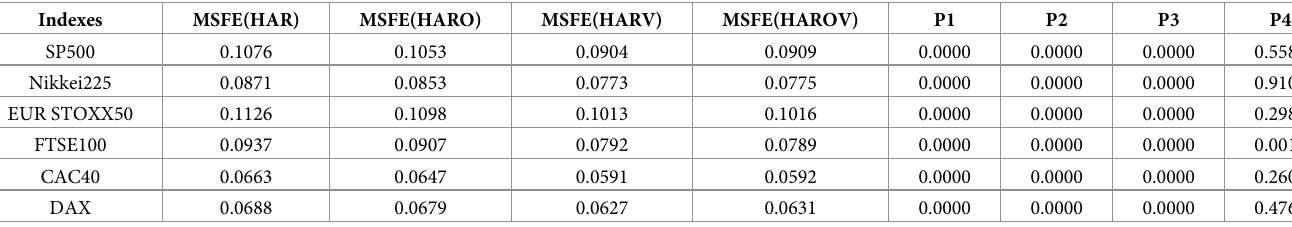
Table 3. Out-of-sample forecasts performance of HAR, HARO, HARV and HAROV.